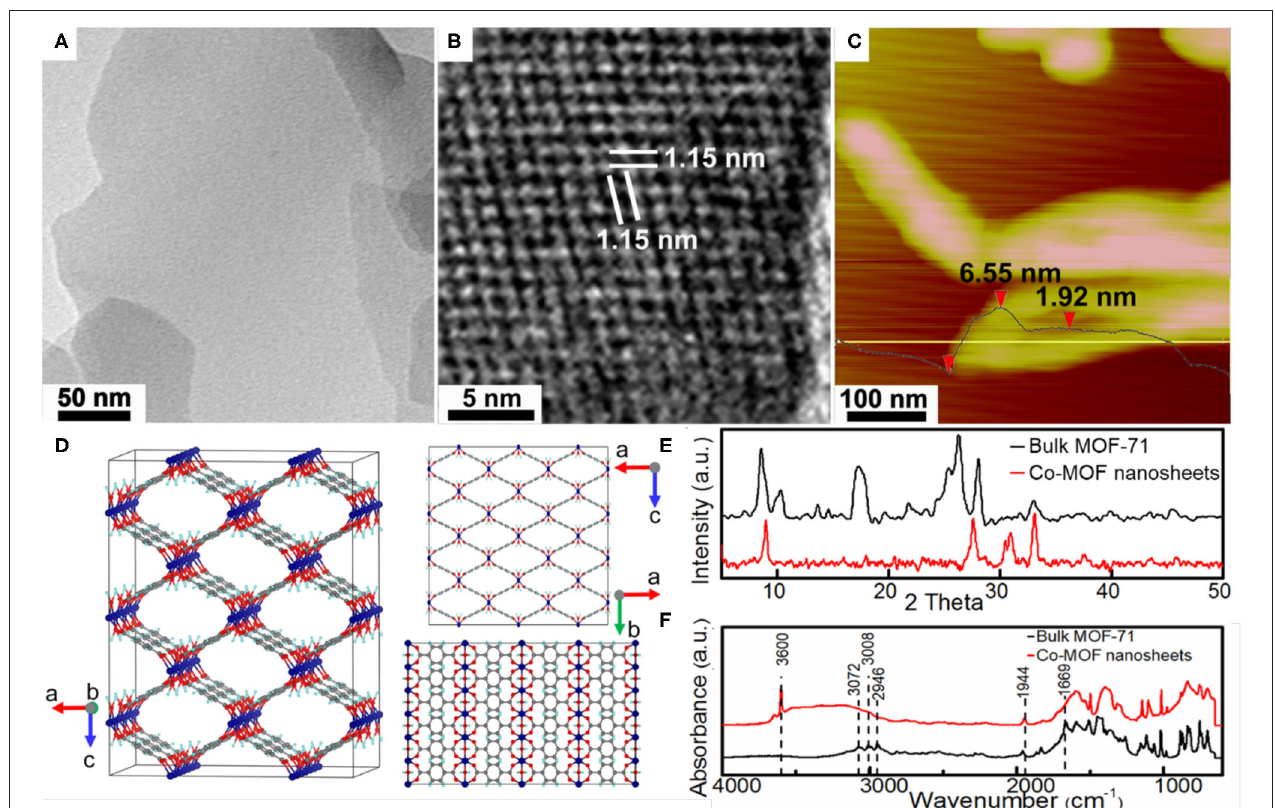
FIGURE 1 | Structural characterizations of the as-synthesized Co-based metal organic framework (Co-MOF) nanosheets: (A) transmission electron microscopy (TEM) image, (B) high-resolution TEM (HRTEM) image, (C) atomic force microscopy (AFM) image, and (D) crystalline structure of bulk MOF-71 (Co, C, O, and H atoms are shown in purple, gray, red, and blue) along different crystallographic axes; (E) X-ray diffraction (XRD) and (F) Fourier transform infrared (FTIR) of bulk MOF-71 and Co-MOF nanosheets.